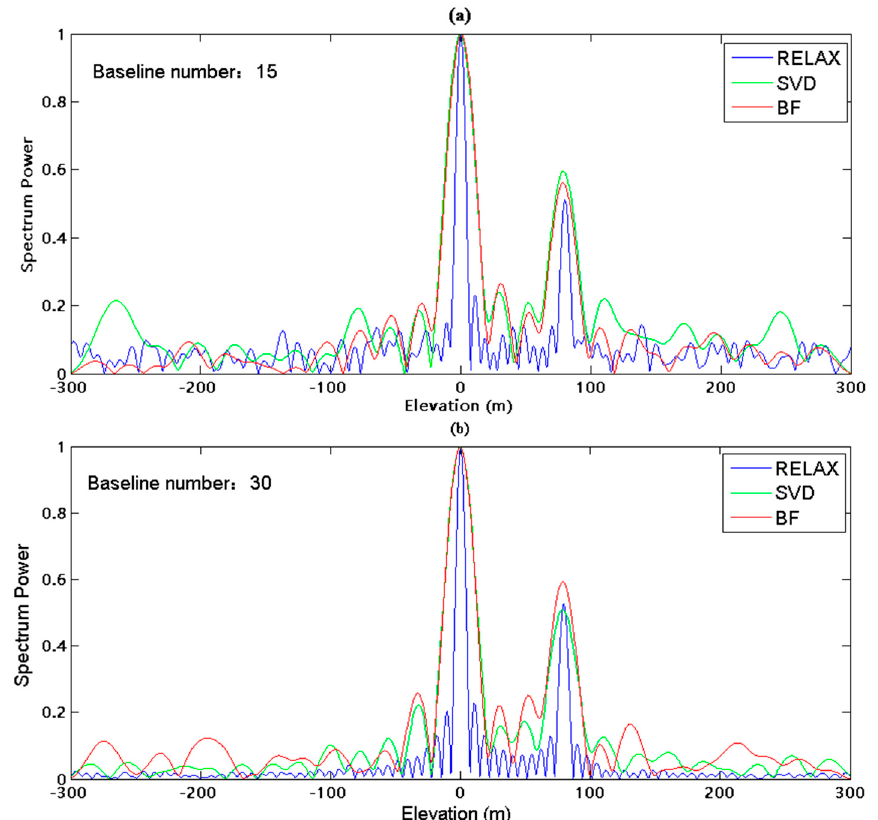
Figure 5. Simulation results of layover scatterers under different numbers of baselines. Hs is 40 m and 80 m, the baseline numbers of ( a ) and ( b ) are 15 and 30 respectively.